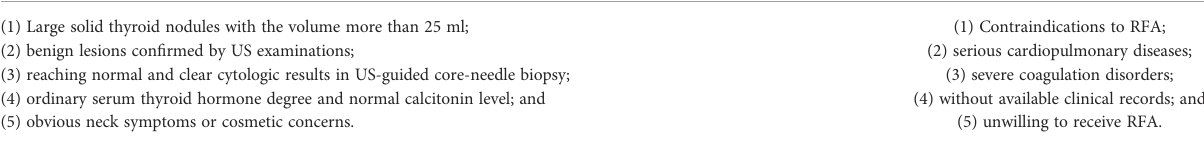
TABLE 1 The inclusion and exclusion criteria for the included